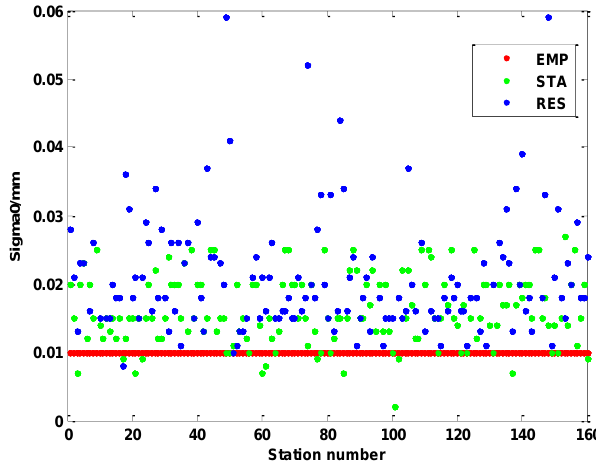
Figure 7. The σ 0 of stations based on different stochastic models. The 3D RMS of the three stochastic models compared with the IGS final products is illustrated in Figure 8. The difference between the fourth and fifth iterations is within 0.1 cm, and the 3D RMS of the third iteration is larger. For different stochastic models, the STA and RES models bring almost no improvement on the fourth and fifth iterations compared with that of the EMP model. From this point of view, it can be concluded that the orbit qualities based on three stochastic models can all reach an accuracy of 3.5 cm when the number of iteration times is sufficient. It is clear that the orbit accuracy is different between different models on the third iteration, and STA and RES models bring improvement compared with that the EMP model. By comparing the results of different days, the accuracy of orbit estimates benefits from the STA and RES models, and these two models bring significant improvement compared with that of the EMP model during the period between DOY 076 and DOY 079. The mean RMS in along-track, cross-track, and radial directions of the estimated GPS orbits of three stochastic models from DOY 076 and DOY 079 are presented in Table 9. For three stochastic models, the differences in three directions are within 0.5 mm on the fourth and fifth iterations for GPS. Therefore, the difference is only analyzed for the third